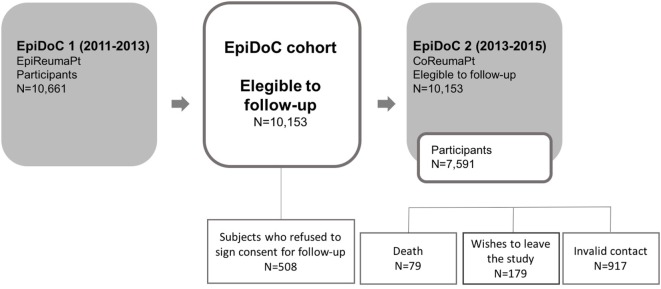
Flowchart of EpiDoc study design.